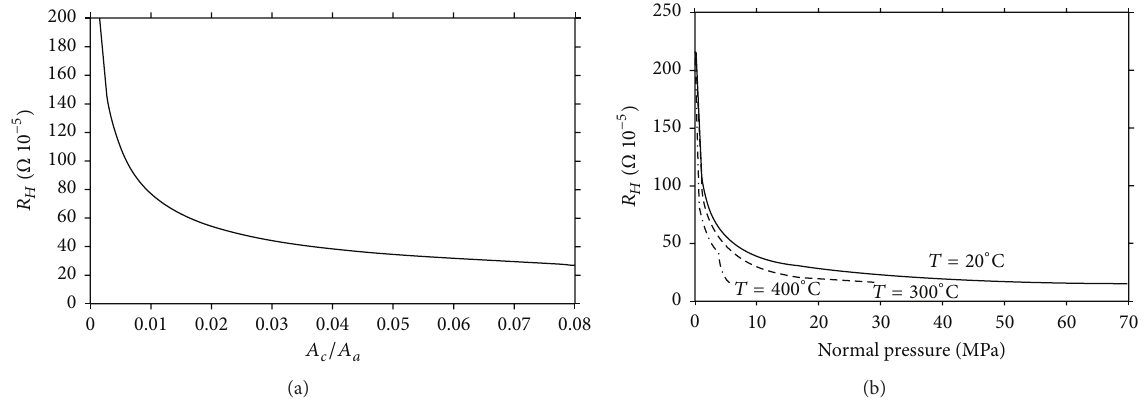
Figure 15: Contact resistance 𝑅 𝑐 versus a -dimensional contact area (a); 𝑅 𝑐 versus normal pressure (b).